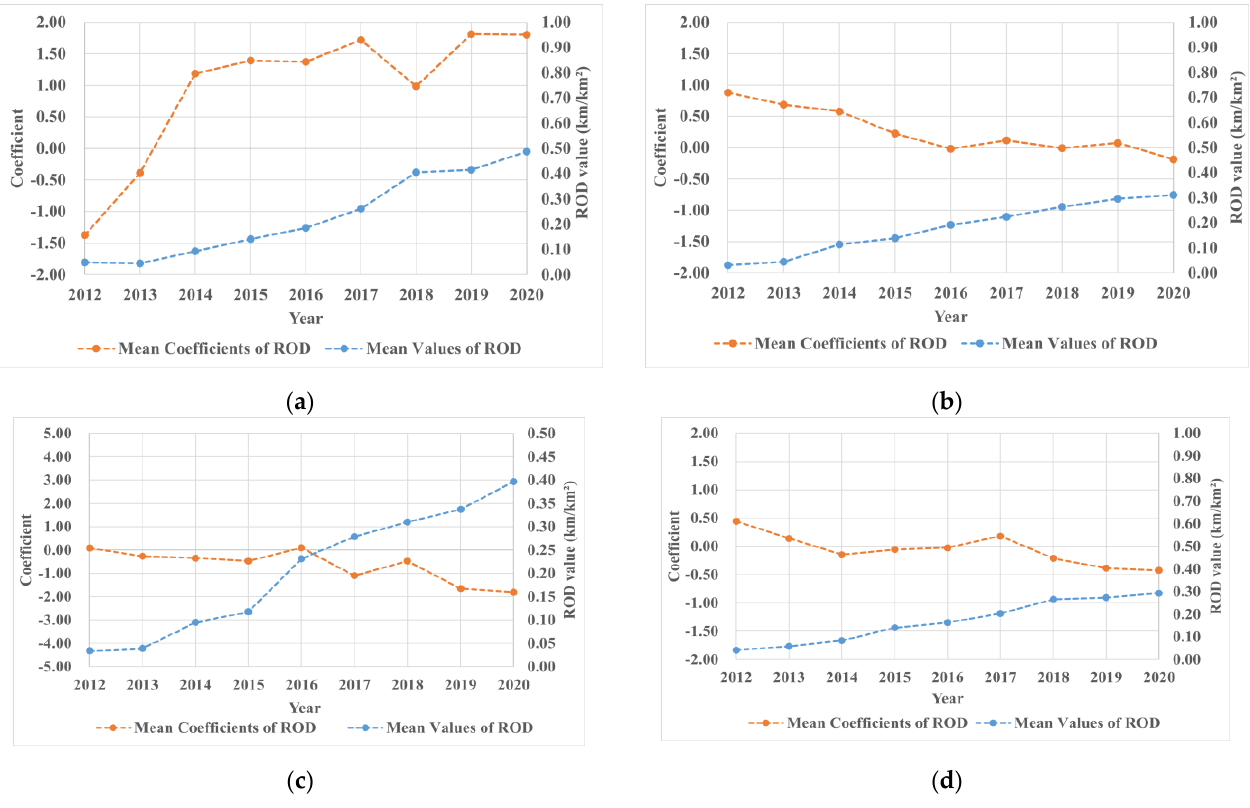
Figure 14. Temporal trends of mean ROD values and mean ROD coefficients in ( a ) Chuzhou; ( b ) Anqing; ( c ) Xuancheng; ( d ) Chizhou.